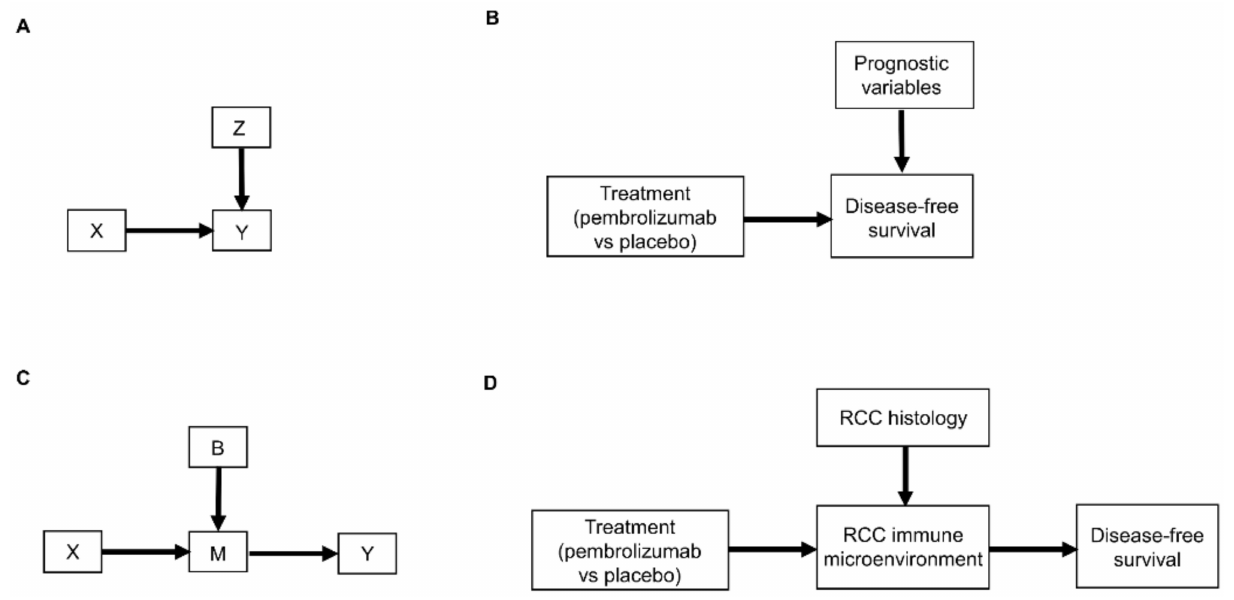
Figure 5. DAGs representing the two modeling strategies recommended by the Predictive Approaches to Treatment effect Heterogeneity (PATH) statement: ( A ) Additive (“risk modeling”) approach where the outcome Y is independently influenced by a treatment X and baseline risk Z; ( B ) Additive modeling scenario whereby DFS is independently influenced by the treatment choice between adjuvant pembrolizumab or placebo and by each patient’s baseline risk as determined by renal cell carcinoma (RCC) prognostic risk models such as the Assure nomogram; ( C ) Interactive “effect modeling” approach where treatment X and baseline biomarker B interact by influencing together the mediator M, transmitting the effect of X on the outcome Y; ( D ) Interactive modeling scenario whereby RCC histology interacts with the treatment choice between adjuvant pembrolizumab or placebo by influencing together the RCC immune microenvironment transmitting the effect of treatment choice on